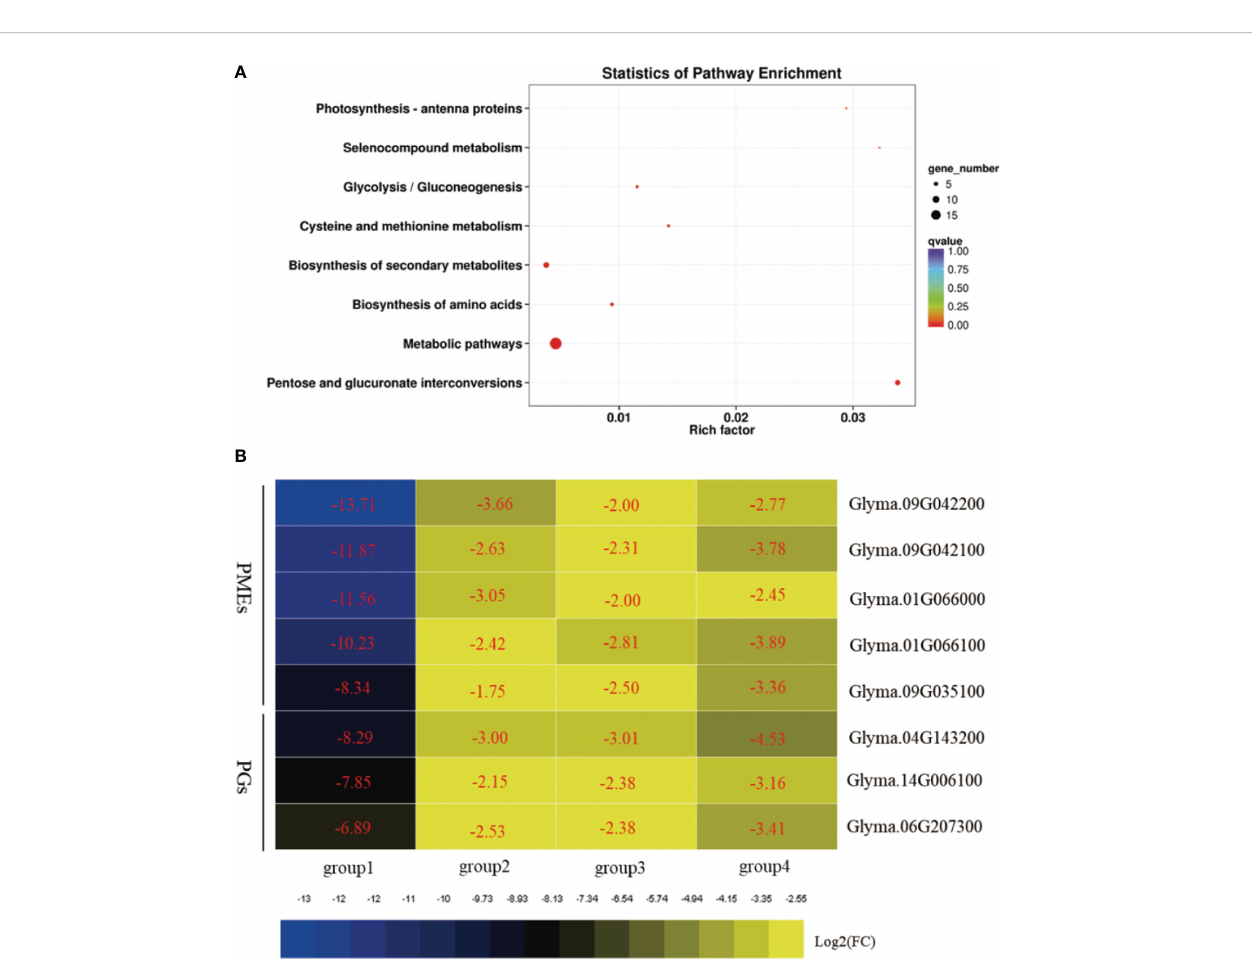
FIGURE 5 Biological pathway analysis of differentially expressed genes (DEGs) and differentially expressed genes (DEPs) shared between the uninucleate microspore (UM) and binucleate pollen (BP) stages. (A) Enriched Kyoto Encyclopedia of Genes and Genomes (KEGG) biochemical pathway terms among the shared DEGs and DEPs. (B) Heatmap illustrating the expression levels of selected pectinesterases (PMEs) and polygalacturonases (PGs) involved in cell wall and pollen tube development. Group1, DEGs in W931A compared to W931B at the UM stage; group2, DEGs in W931A at the BP stage; group3, DEPs in W931A at the UM stage; group4, DEPs in W931A at the BP